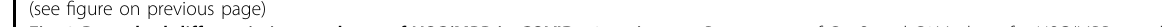
Fig. 3 Perturbed differentiation tendency of HSC/MPP in COVID-19 patients. a Percentages of G1, S, and G2M phase for HSC/MPP population from HC and COVID-19 patients. b Enriched GO terms of up-regulated genes in the HSC/MPP population from COVID-19 patients. Three pathways were clustered into immune response-associated pathways, three were identi fi ed associated with virus response, two were related to apoptosis and autophagy, and fi ve pathways participated in the processes of differentiation. c Heatmap showing the signi fi cant different expression patterns of IFN- stimulated genes in the HC, mild, and severe groups. d GSEA analysis of transcriptome comparisons in HSC/MPP shows that the KEGG pathway “ Apoptosis ” (Entry ID: hsa04210) was enriched in COVID-19 patients vs controls. e Proportion of Annexin V + HSC in total HSC with fl ow cytometry. Results were compared among the HC, mild group, and severe group and two positive controls (PC). f Stemness signature scores of HSPCs from HC, mild, and severe patients projected onto 2c graph. Red color represents a higher stem score. g , h Gene pairwise Spearman correlation within the 90% – 95% (HC) and 95% – 100% (Mild group, Severe group) of the stem score. g The projection of corresponding cells onto the core model with corresponding percentile. h The heatmap of gene pairwise Spearman correlation. i RNA velocity analysis of HSPC cells among the HC, mild, and severe group. Upper panel projects the velocity fi eld onto the UMAP plot of HSPC in the three groups. Lower panel shows the numbers and ratios of predicted differentiation endpoint of HSC/MPPs in the three